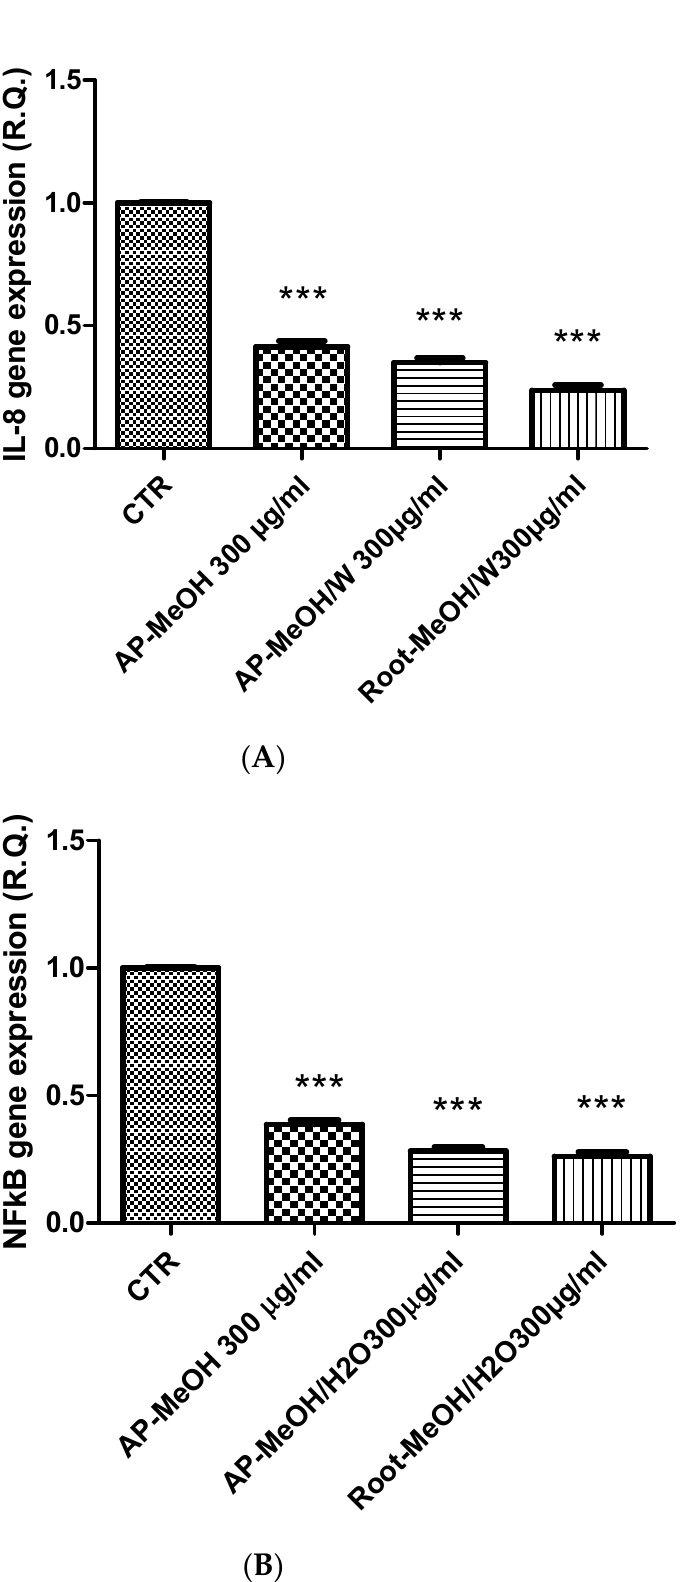
Figure 4. Inhibitory effects of IL-8 ( A ) and NFkB ( B ) gene expression induced by the methanol (MeOH) and methanol/water (MeOH/W) extracts of aerial parts (AP) and roots from Epilobium hirsutum (100–300 µg/mL). ANOVA, p < 0.0001, *** p < 0.001 vs. CTR (Control) group.